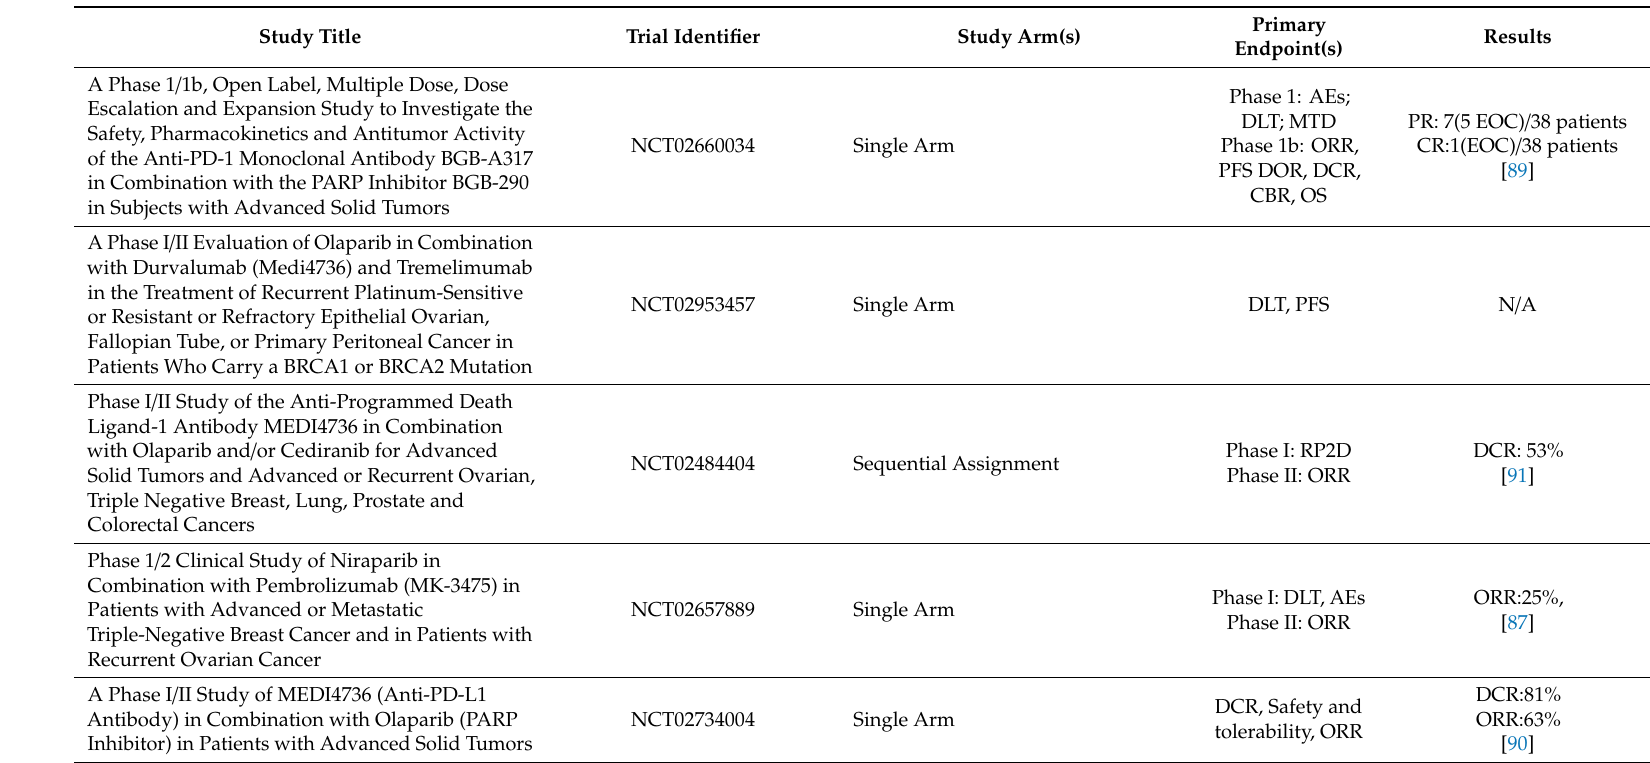
Table 3. PD-1 and anti-PARP